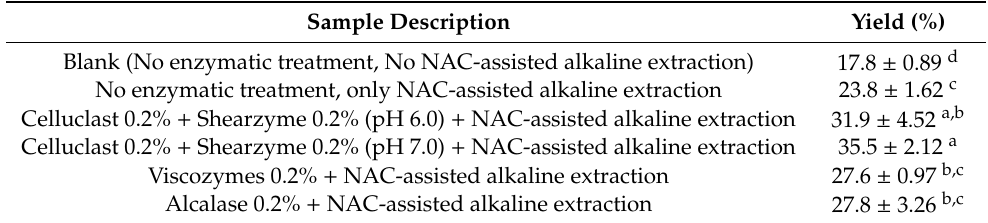
Table 3. E ff ect of protein extraction on the yield (%) of isolated carrageenan of seaweed Eucheuma denticulatum treated with di ff erent enzymes followed by NAC-assisted alkaline extraction. Yields are given in average ± standard deviation. Di ff erent superscripts letters in the same column indicate significant di ff erence at the confidence level of 95% ( α = 0.05; n =